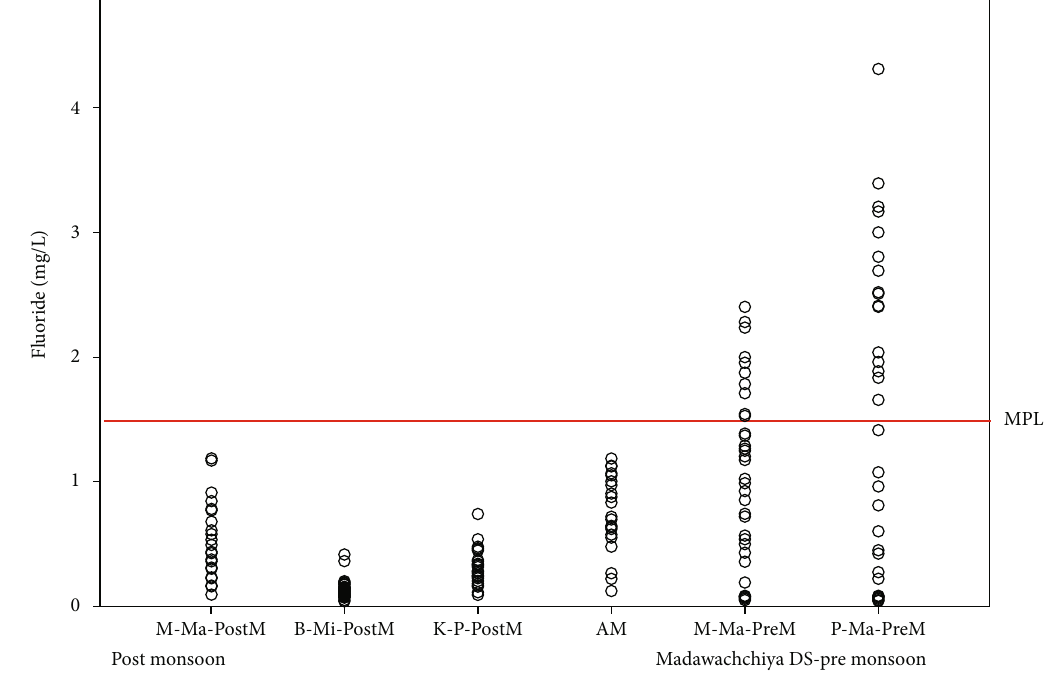
Figure 3: Fluoride content of well water samples in the study